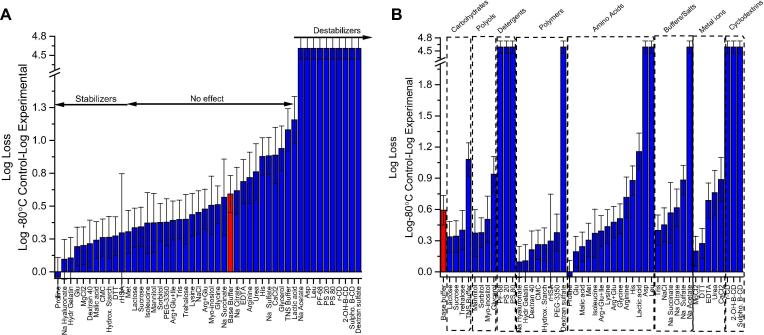
Log loss of rHCMV-1 infectivity titer after storage for 3 days at 4 °C in the presence of 48 different excipients. (A) Excipients listed in order of protective effect on viral vector stability, and (B) excipients listed by class of additives. The rHCMV-1 stock was diluted 1:150 into each excipient containing solution in a base buffer (20 mM sodium phosphate, 150 mM NaCl, pH 7.5) in polypropylene microcentrifuge tubes, subjected to incubation at 4 °C for 3 days, and analyzed by IE-IFA. Log loss of viral titer was calculated by subtracting the log (titer) of the control sample, which was rHCMV-1 bulk diluted 1:150 in TNS buffer and stored at −80 °C, from the log(titer) of the experimental formulations after storage at 4 °C for 3 days. Stability data are an average of three measurements and the error bars represent the standard deviation. The viral vector in base buffer alone (20 mM sodium phosphate, 150 mM NaCl, pH 7.5) is indicated by the red colored bar.